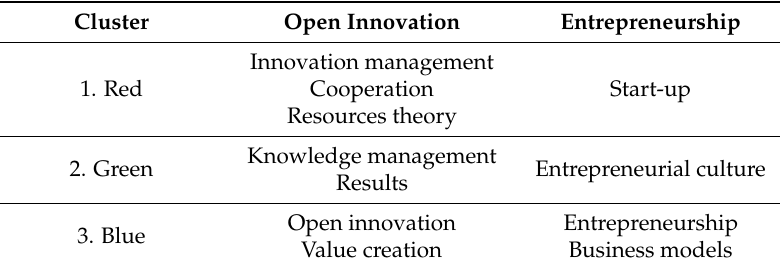
Table 11. Clusters and